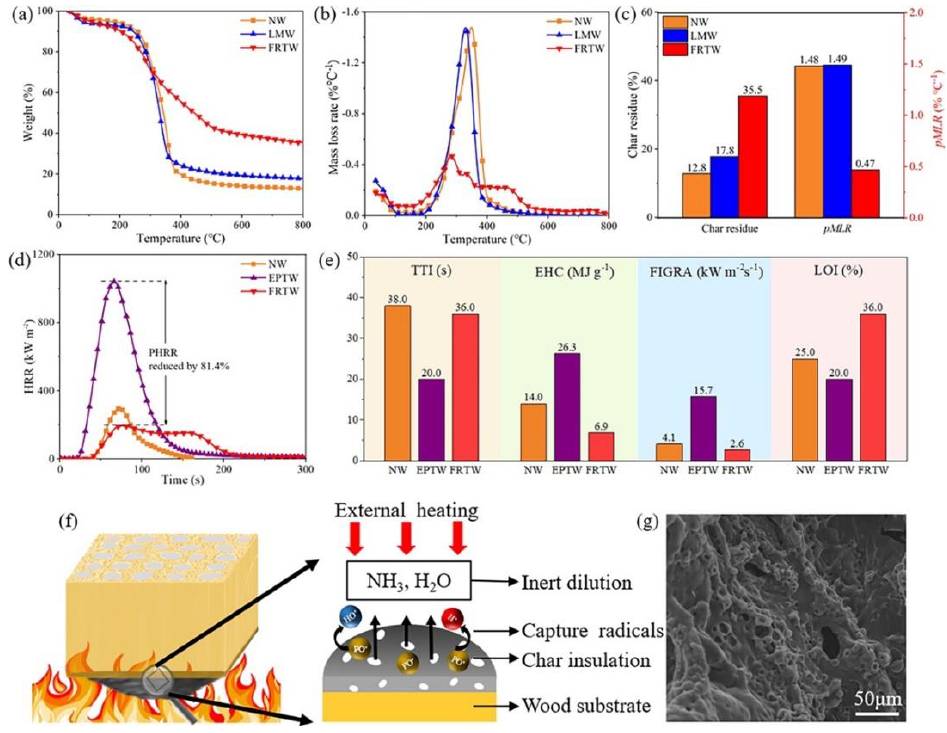
(EHC), fire growth rate index (FIGRA), and limiting oxygen index (LOI) for NW, EPTW, and FRTW.